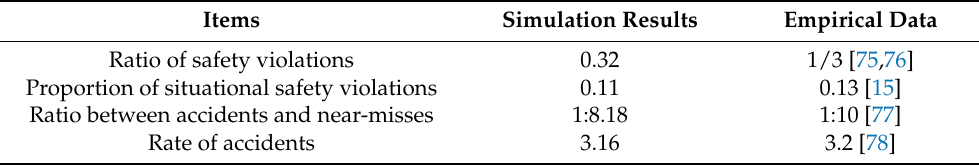
Table 2. Quantitative agreement between the simulation results and empirical